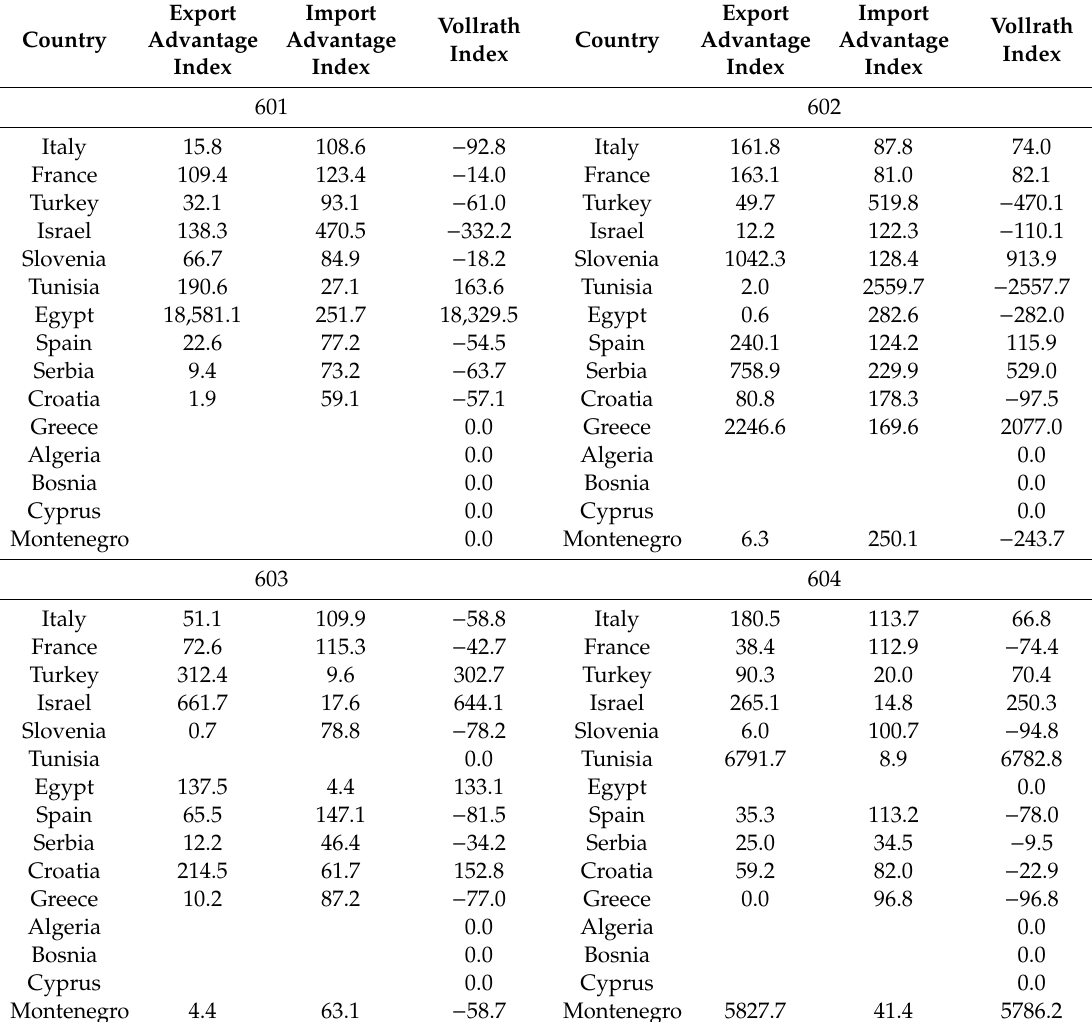
Table 5. Performance indices of the main Mediterranean Basin countries in plant material trade for non-food uses (UN Comtrade code 06, by subcode)